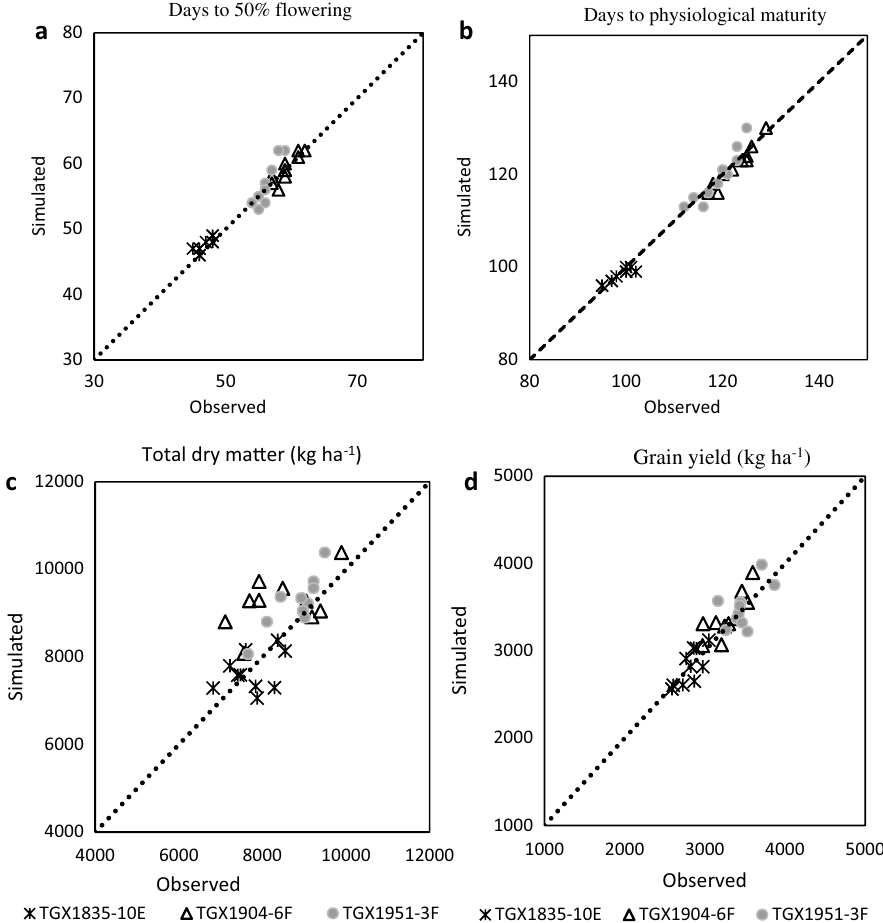
Figure 1. ( a ) Observed vs. simulated days to 50% flowering using calibration experiment conducted 2016–2019 growing seasons for cultivar TGX1835-10E (RMSE = 0.95 kg ha −1 , RMSE n = 2.0%, D = 0.8); TGX1904-6F (RMSE = 0.89 kg ha −1 , RMSE n = 1.5%, D = 0.93); TGX1951-3F (RMSE = 1.95 kg ha −1 , RMSE n = 3.5%, D = 0.83). ( b ) Observed vs. simulated days to days to physiological maturity using calibration experiment conducted 2016– 2019 growing seasons for cultivar TGX1835-10E (RMSE = 1.18 kg ha −1 , RMSE n = 1.2%, D = 0.9); TGX1904-6F (RMSE = 1.34 kg ha −1 , RMSE n = 1.1%, D = 0.97); TGX1951-3F (RMSE = 2.21 kg ha −1 , RMSE n = 1.9%, D = 0.94). ( c ) Observed vs. simulated total dry matter using calibration experiment conducted 2016–2019 growing seasons for cultivar TGX1835-10E (RMSE = 545.42 kg ha −1 , RMSE n = 7.1%, D = 0.63); TGX1904-6F (RMSE = 1111.03 kg ha −1 , RMSE n = 13.3%, D = 0.6); TGX1951-3F (RMSE = 538.46 kg ha −1 , RMSE n = 6.1%, D = 0.8). ( d ) Observed vs. simulated grain yield using calibration experiment conducted 2016–2019 growing seasons for cultivar TGX1835-10E (RMSE = 125.84 kg ha −1 , RMSE n = 4.5%, D = 0.85); TGX1904-6F (RMSE = 177.44 kg ha −1 , RMSE n = 5.4%, D = 0.85); TGX1951-3F (RMSE = 197.74 kg ha −1 , RMSE n = 5.7%, D =